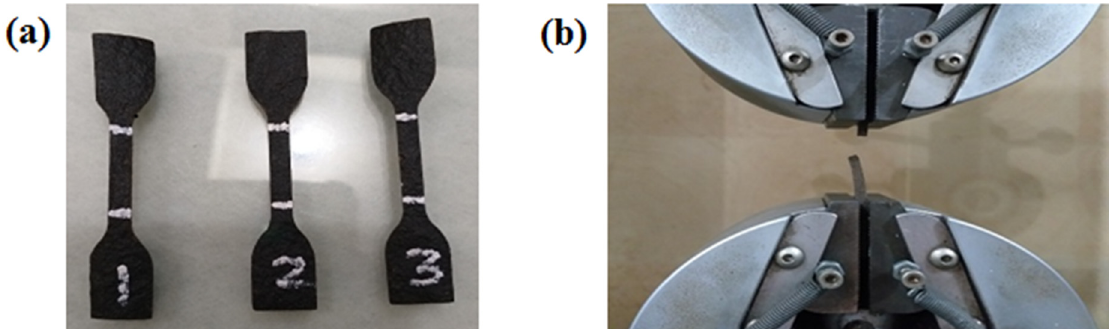
Figure 1. ( a ) Prepared samples for the tensile test and ( b ) a sample during the tensile